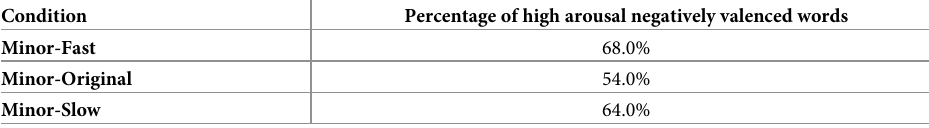
Table 5. The percentage of high arousal words with negative valence chosen in the minor